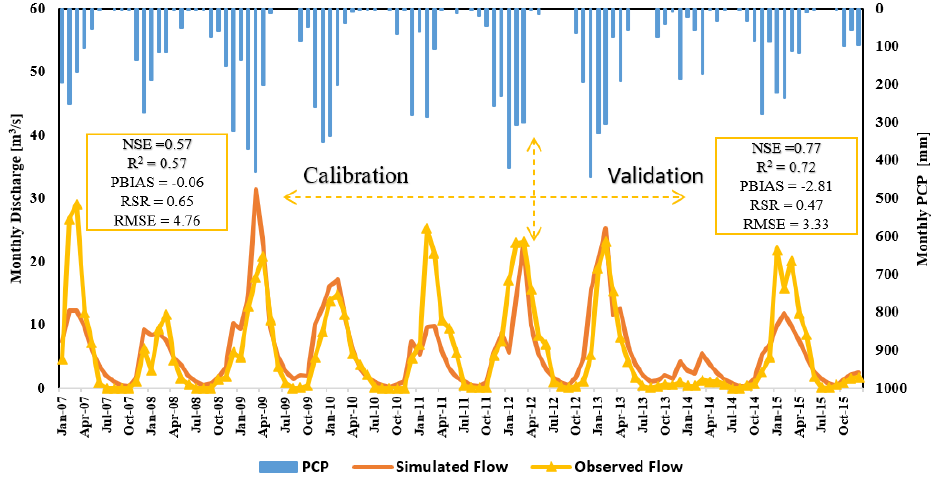
Figure 6. Monthly flow results of SWAT model simulation at station F.1 (Seamouth) as compared to historical recorded flows (PCP = precipitation).